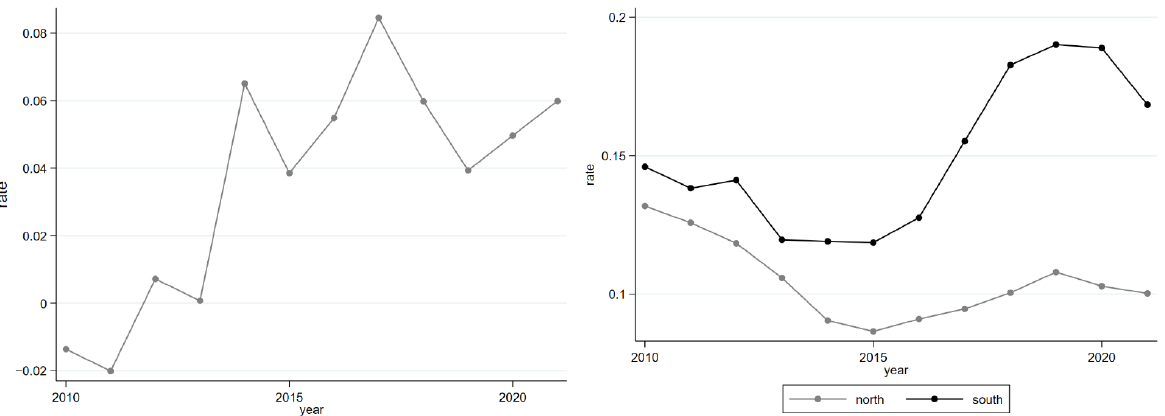
Figure 4. Northern PM 2.5 concentration ratio and northern- southern ratio of applicants’